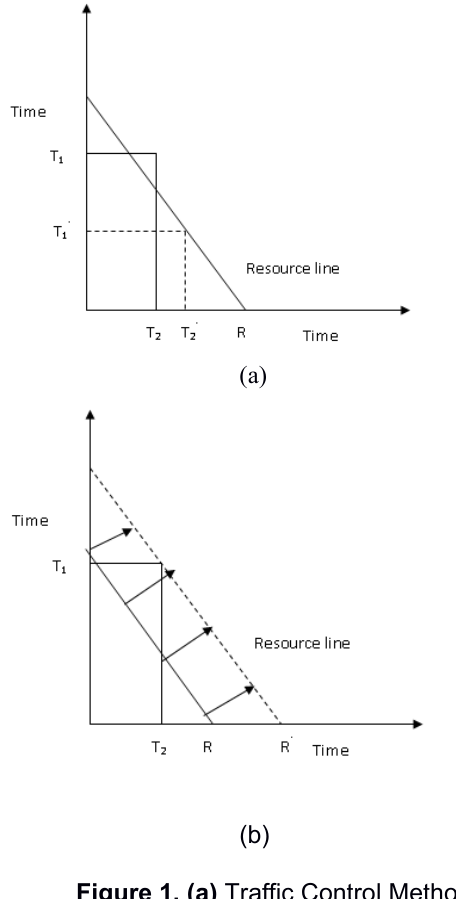
Figure 1. (a) Traffic Control Method (b) Resource Control Method